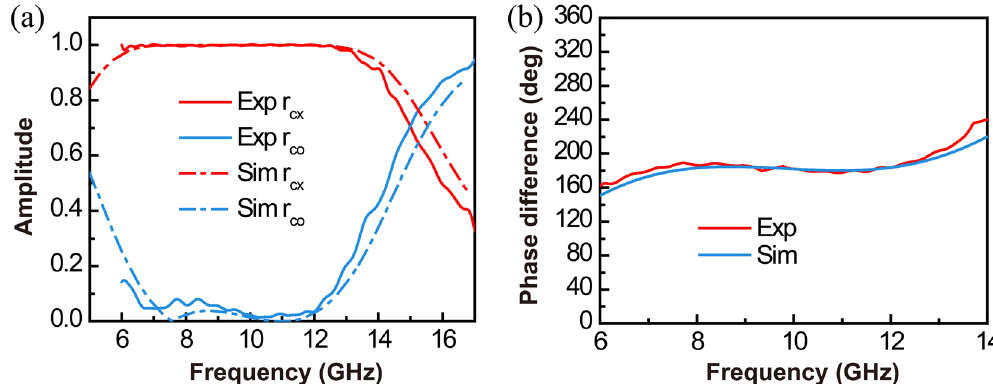
Figure 3. Experimental and numerical results for the proposed half-wave plate operating under quasi-normal incidence. ( a ) Amplitude coefficients for the co-polarized and cross-polarized components of the reflected beam. ( b ) Phase difference of the reflected beams between cases where the polarizations of the input beam are parallel and perpendicular to the grating wires. Note that the incident angle is 5